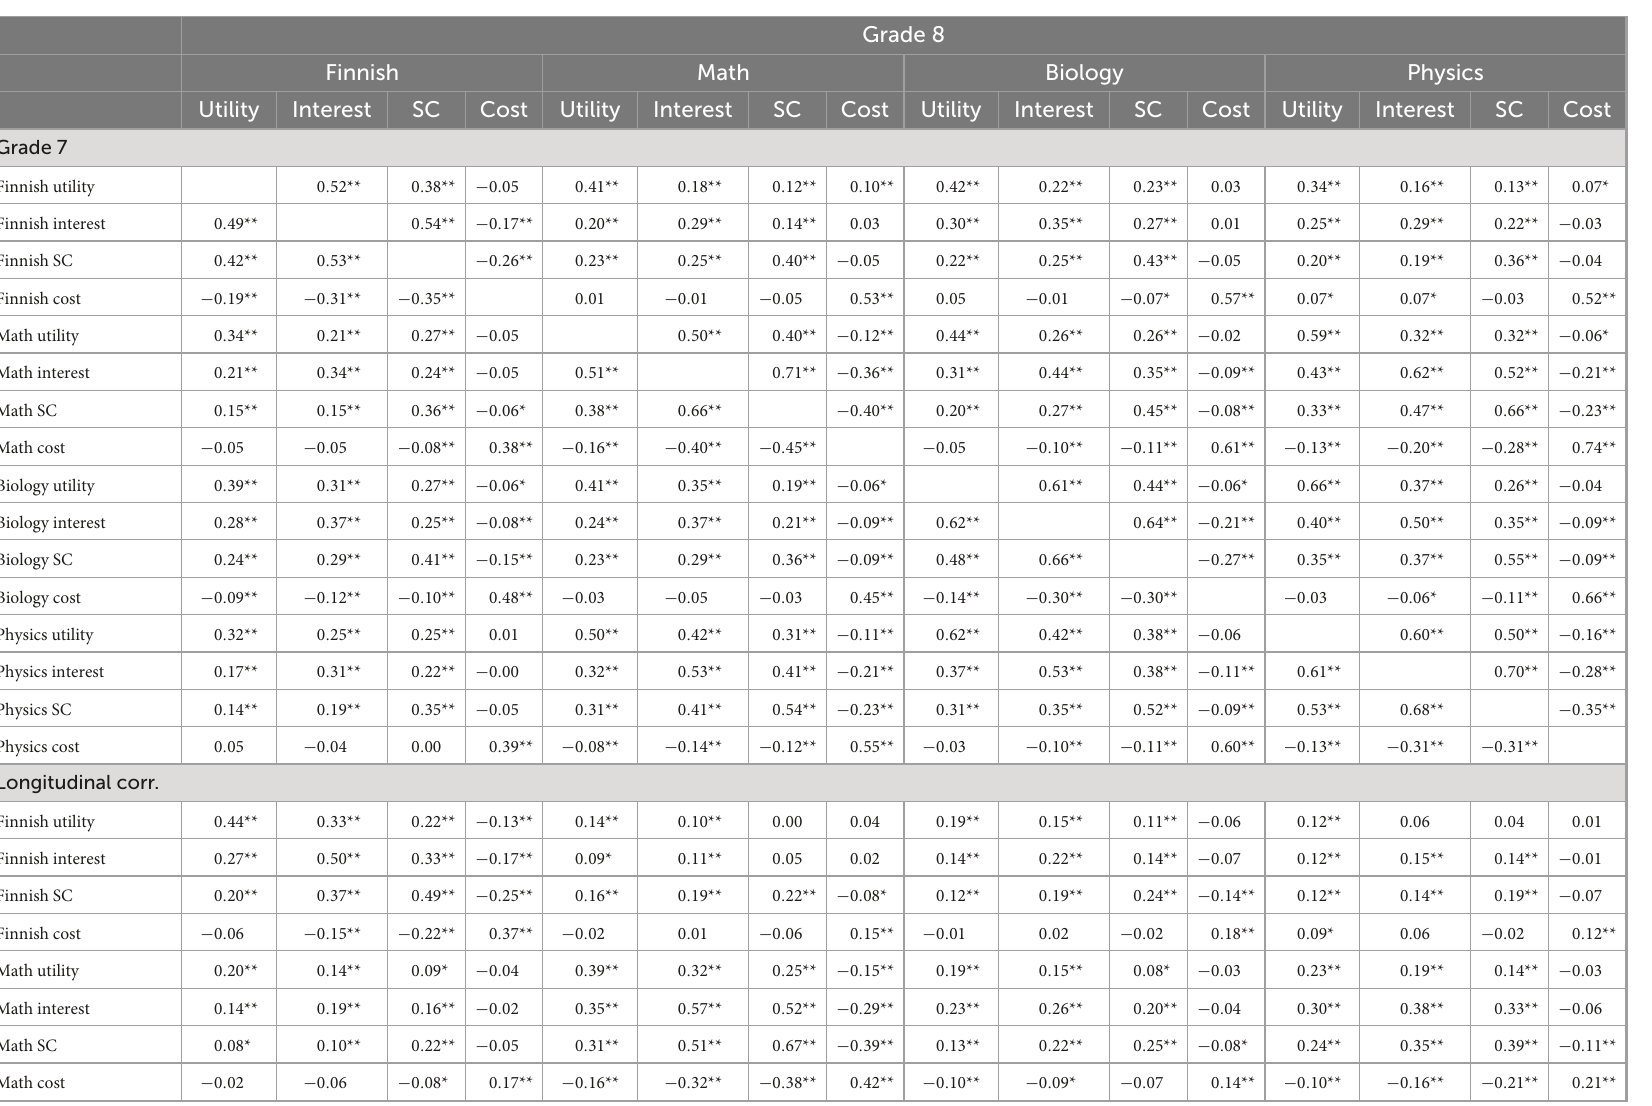
TABLE 1 Descriptive data and correlations of the study